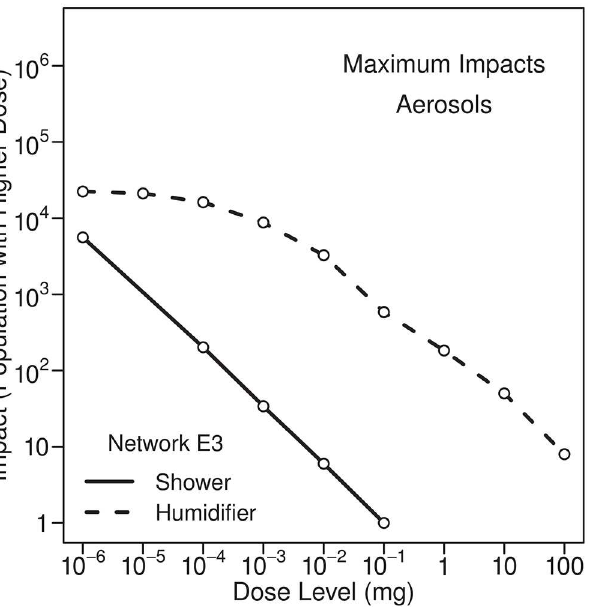
Fig 13. Maximum impacts associatedwith inhalation of contaminated aerosols during showering and humidifier use. Results are for Network E3 and an injectionat 0:00 with a mass equal to 10 kg. Ultrasonic humidifiers are assumed to be filled at 22:00 hours and used for eight hours each day by 20% of the population.